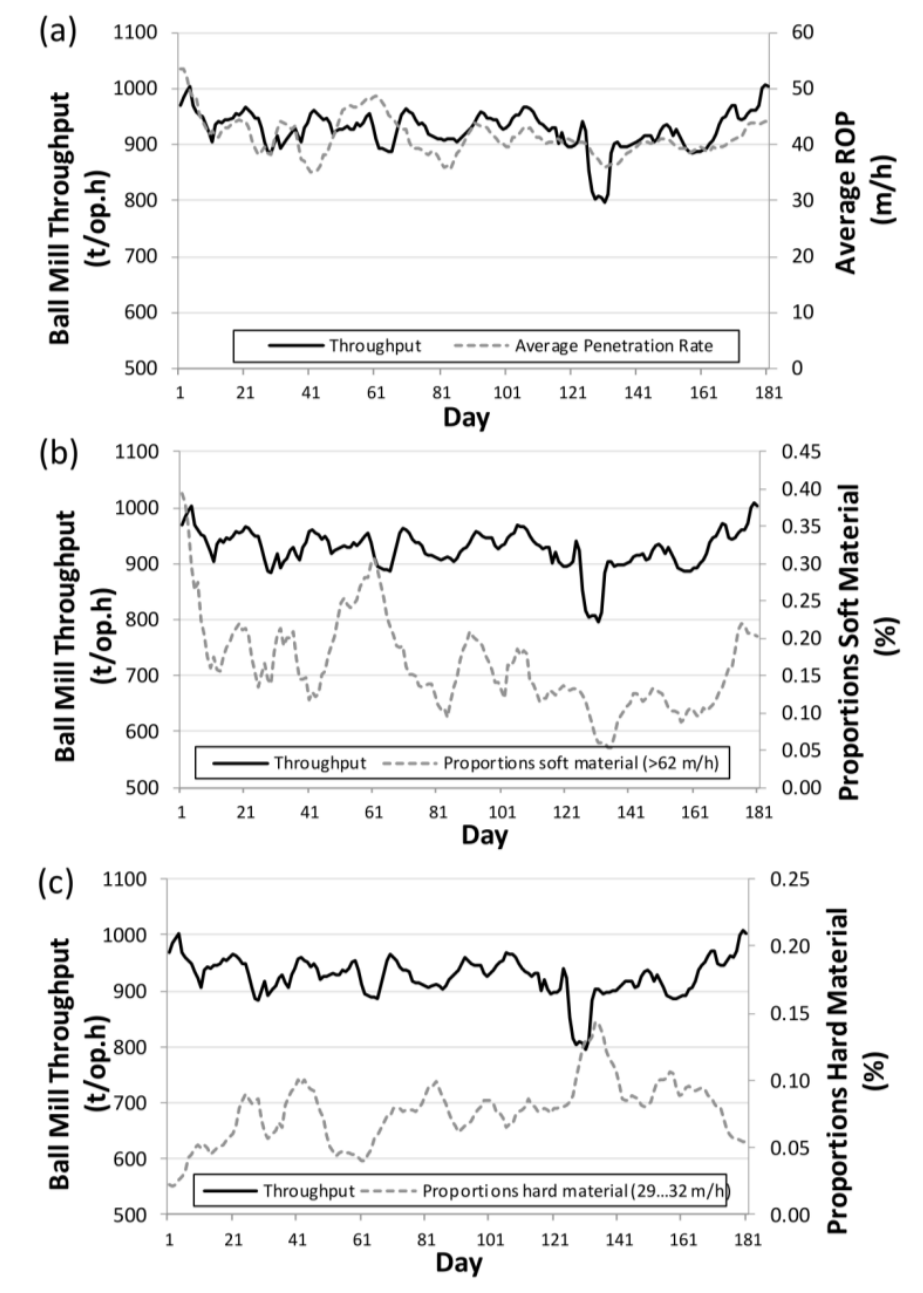
Figure 5. Moving average of ball mill throughput compared to moving average of ( a ) average rate of penetration (ROP), ( b ) proportions of softer material (high penetration rates in the interval >62 m/h), and ( c ) proportions of harder material (low penetration rates falling in the interval of 29–32